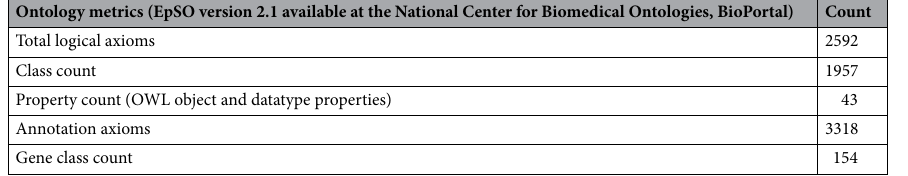
Table 1. Ontology metrics including classes representing epilepsy related